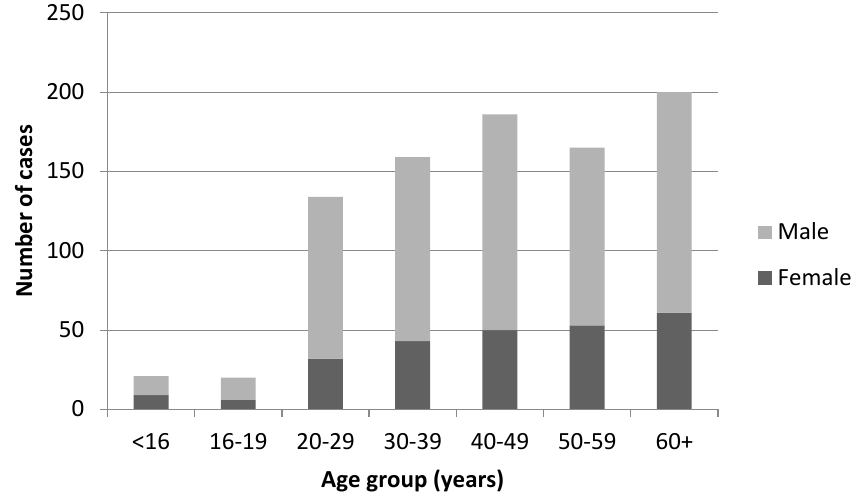
Figure 2. Acute Q fever diagnoses (including outbreak cases) 2000–2015, by age group and sex.